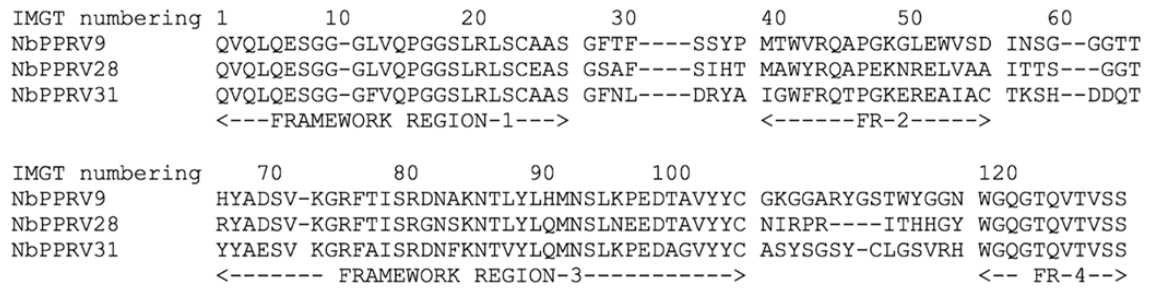
Figure 1. Alignment of single domain antibody sequences of three nanobody families that recognise peste des petits ruminants virus antigens in enzyme-linked immunosorbent assay based on complementarity determining regions (CDRs) of nanobody.